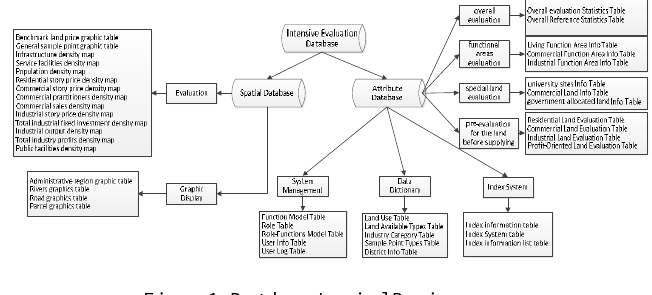
Figure 1. Database Logical Design